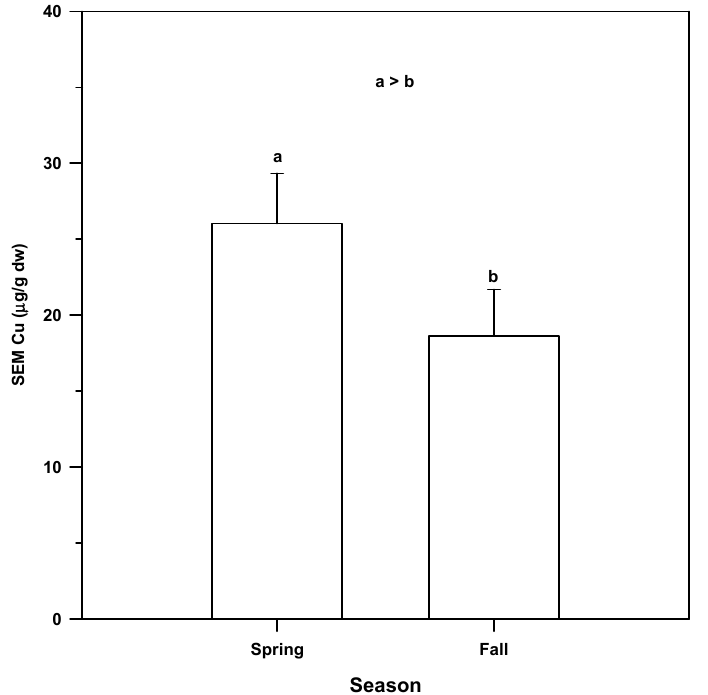
Figure 21. All Cache Slough SEM Cu sediment data for the year 2014 by season. a,b: Spring is significantly greater than Fall ( t -test, p = 0.003).